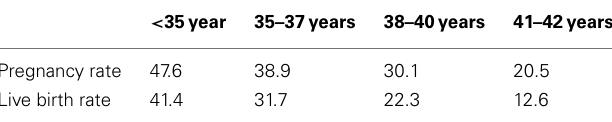
Table 3 | Pregnancy and live birth rates according to different age groups for IVF-treatment (Assisted ReproductiveTechnology,